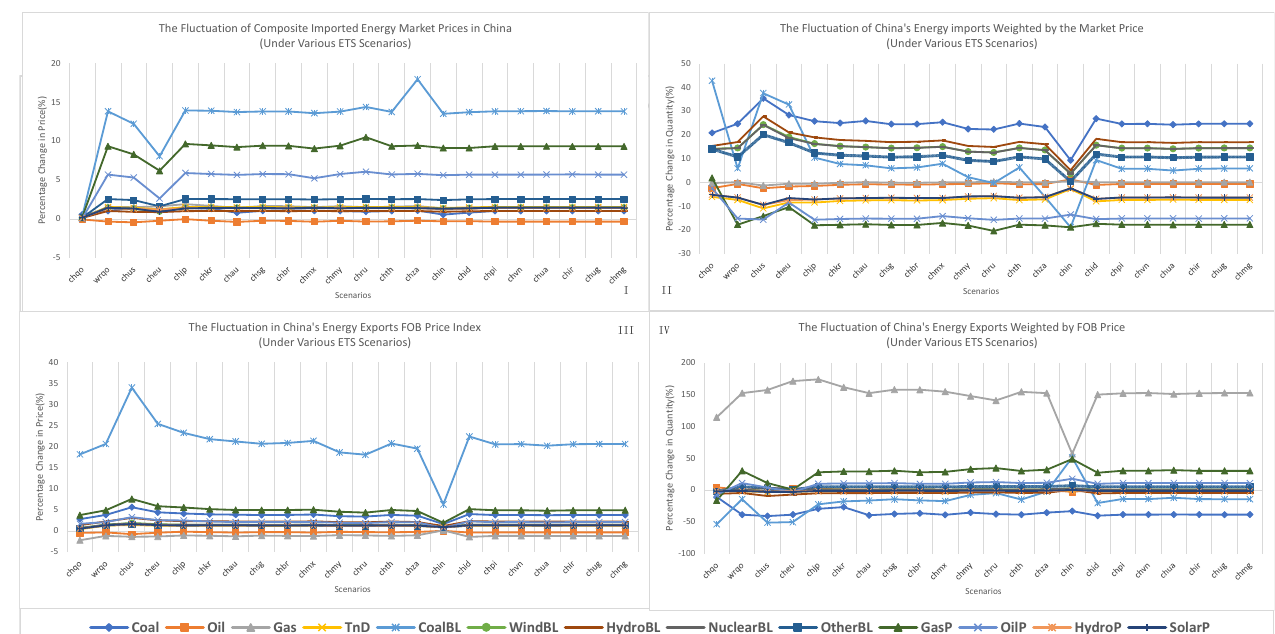
Figure 6. Fluctuations in China’s international energy trade. ( I , IV ), under domestic ETS and ETS linking scenarios, fluctuation of China’s imported energy market price ( I ), its energy imports weighted by the market price ( II ), its energy exports FOB price index ( III ), and its energy exports weighted by FOB price ( IV ).